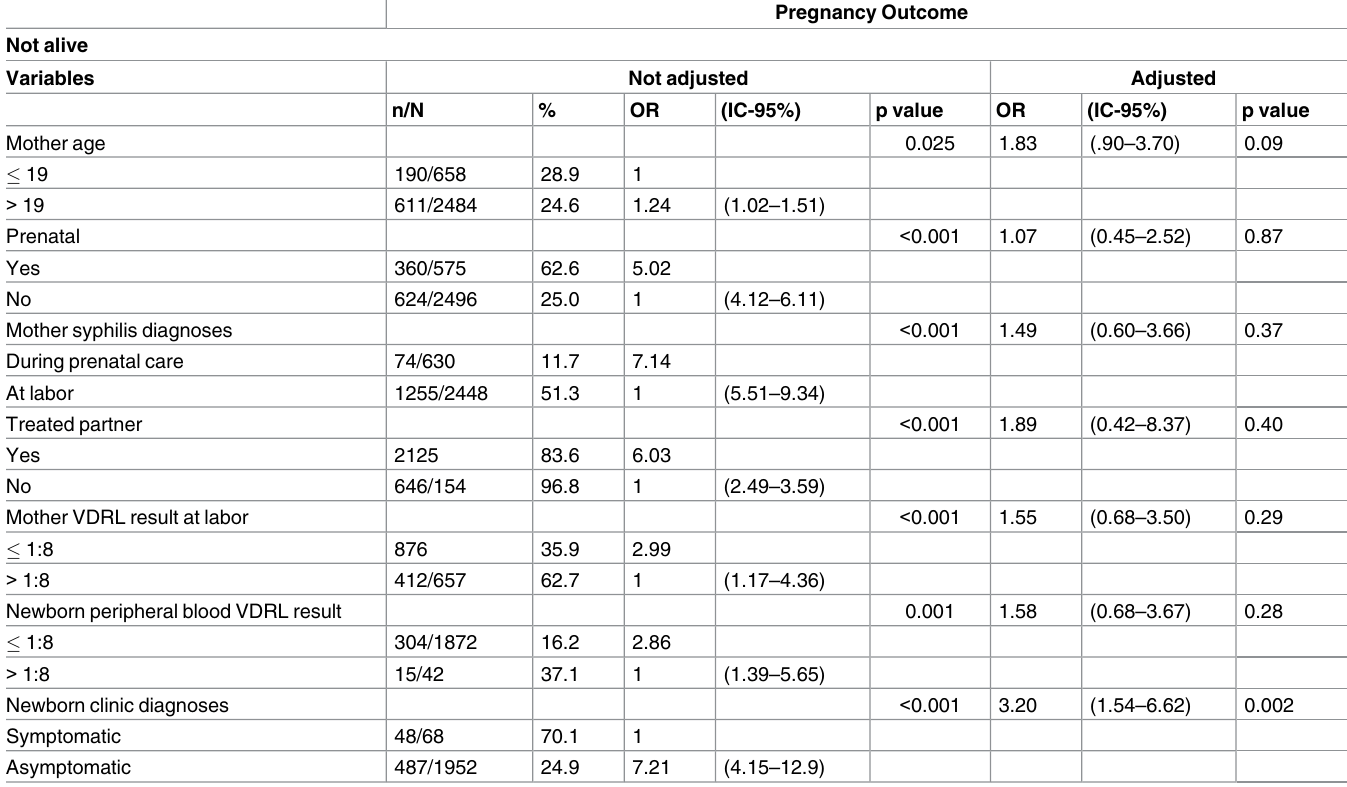
Table 3. Pregnancy outcome after adjusted and not adjusted multivariable logistic regression analysis. Fortaleza—Ceara´,